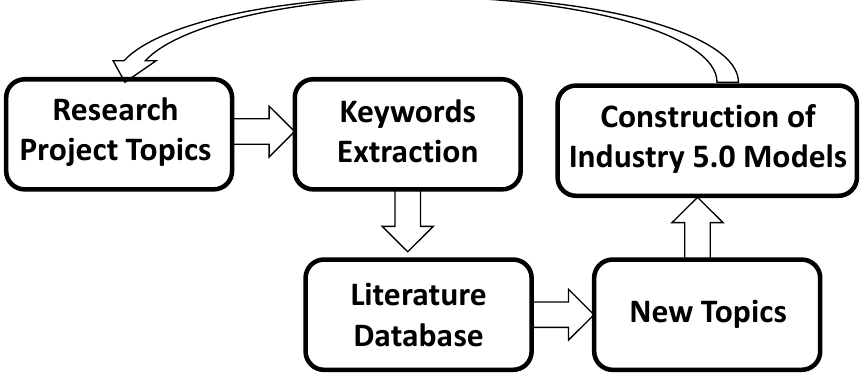
Figure 2. Block diagram of the adopted methodology followed to construct the proposed work.